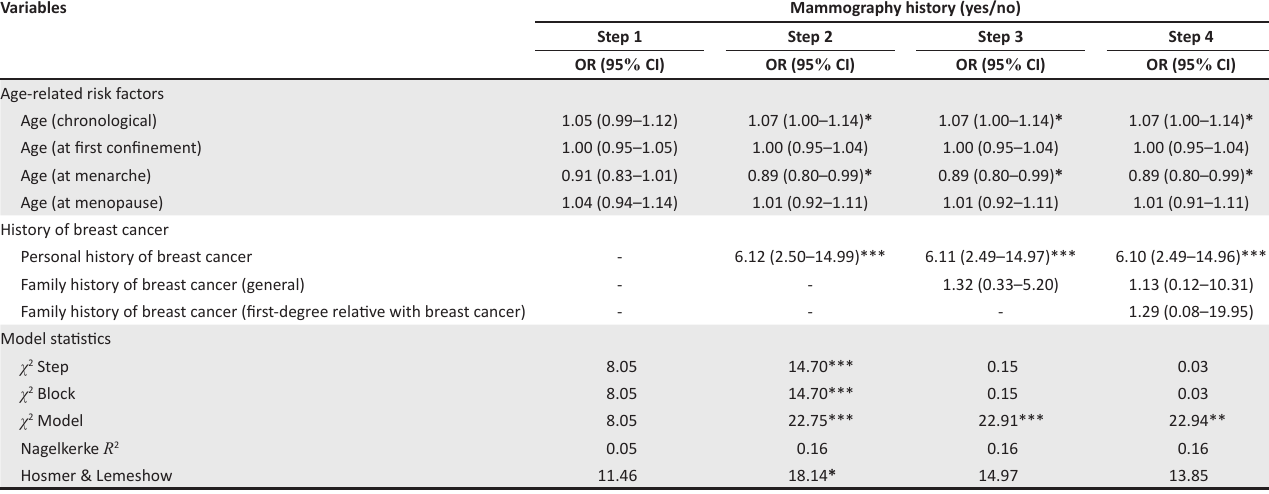
TABLE 2: Results of hierarchical logistic regression predicting mammography history from age-related risk factors and family history.